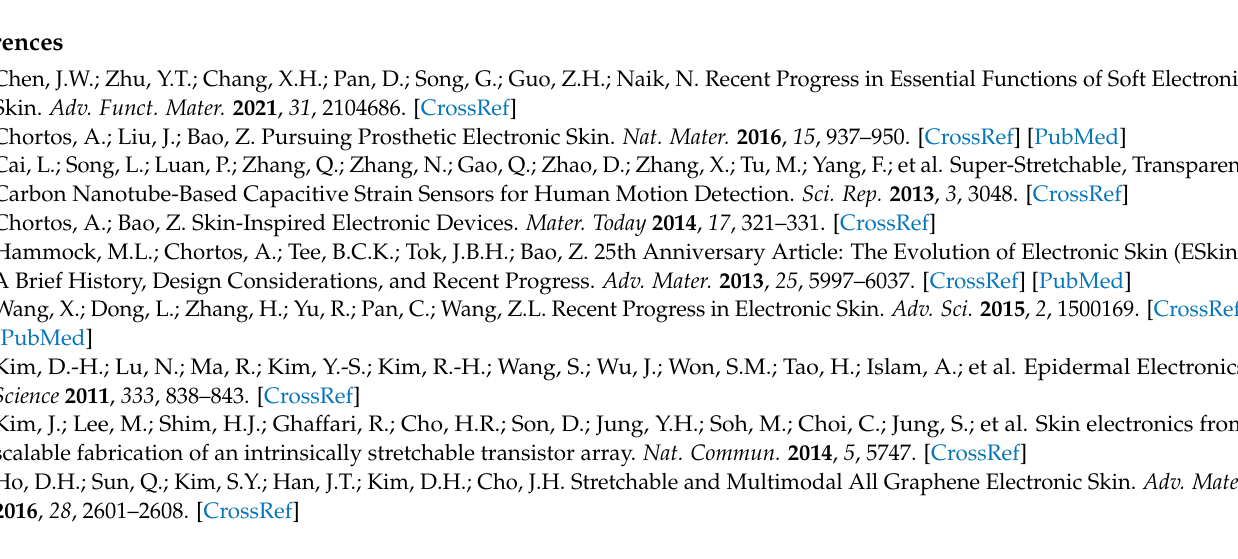
GSFET array.; Figure S3: AFM (atom force microscopy) of the monolayer graphene (left panel) and trilayer graphene scrolls (right panel); Figure S4: Raman characteristic of graphene under strain. Left panel: comparison of Raman spectrum of the CVD single-layer graphene under no strain (blue line) and under a 5% strain (green line). Right panel: comparison of Raman spectrum of the trilayer graphene scrolls under no strain (blue line) and under a 5% strain (green line); Figure S5: Electrical properties of GFET/GSFET under strain deformation (a) Output curve (left panel) and transfer curve (at the given V D = 0.1 V, right panel) of GSFET under no strain deformations. (b) Output curve (left panel) and transfer curve (at the given V D = 0.1 V, right panel) of GSFET under 5% strain deformations. (c) Output curve (left panel) and transfer curve (at the given V D = 0.1 V, right panel) of GFET under no strain deformations. (d) Output curve (left panel) and transfer curve (at the given V D = 0.1 V, right panel) of GFET under 5% strain deformations; Figure S6: Left panel: comparison of Raman spectrum of the CVD single-layer graphene under room temperature (blue line), 30 °C (red line) and under a 5% strain (green line). Right panel: comparison of Raman spectrum of the tri-layer graphene scrolls under room temperature (blue line), 30 °C (red line) and under a 5% strain (green line); Figure S7: Triboelectrical performances of GFET/GSFET by tribo-potential between ion gel and PTFE (a) Circuit diagram of tribotronic GFET/GSFET sensor contact with PTFE. (b) Output curve (left panel) and transfer curve (at the given V D = 0.1 V, right panel) of GFET powered by tribopotential between ion gel and PTFE under no strain deformations. (c) Output curve (left panel) and transfer curve (at the given V D = 0.1 V, right panel) of GSFET powered by tribopotential between ion gel and PTFE under no strain deformations; Figure S8: Schematic illustration of degradation of triboelectric responsiveness of trilayer GSFET comparing to monolayer graphene FET; Figure S9: The I D response time of the